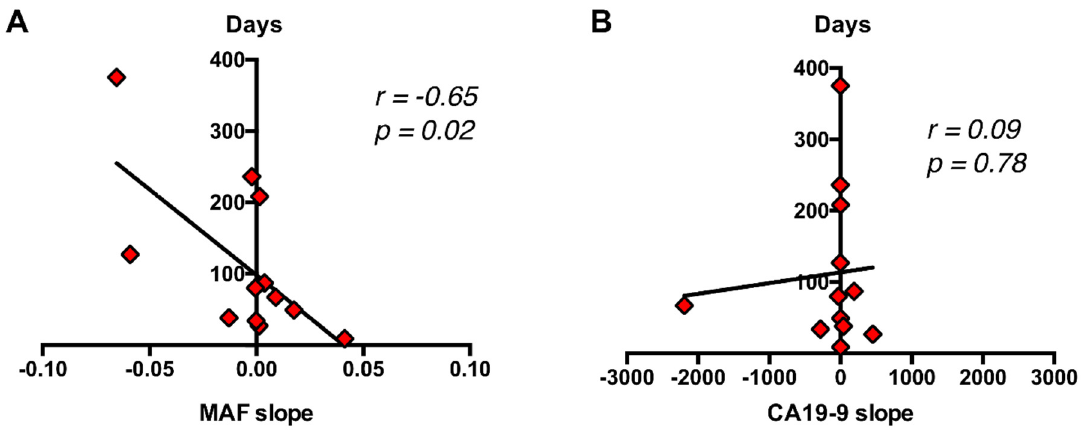
Figure 9. Correlation of dynamics of circulating RAS MAF and CA19-9 with patient’s outcome and survival. ( A ) A significant correlation was found between the increase in MAF ( B ), but not in CA19-9 and survival time.